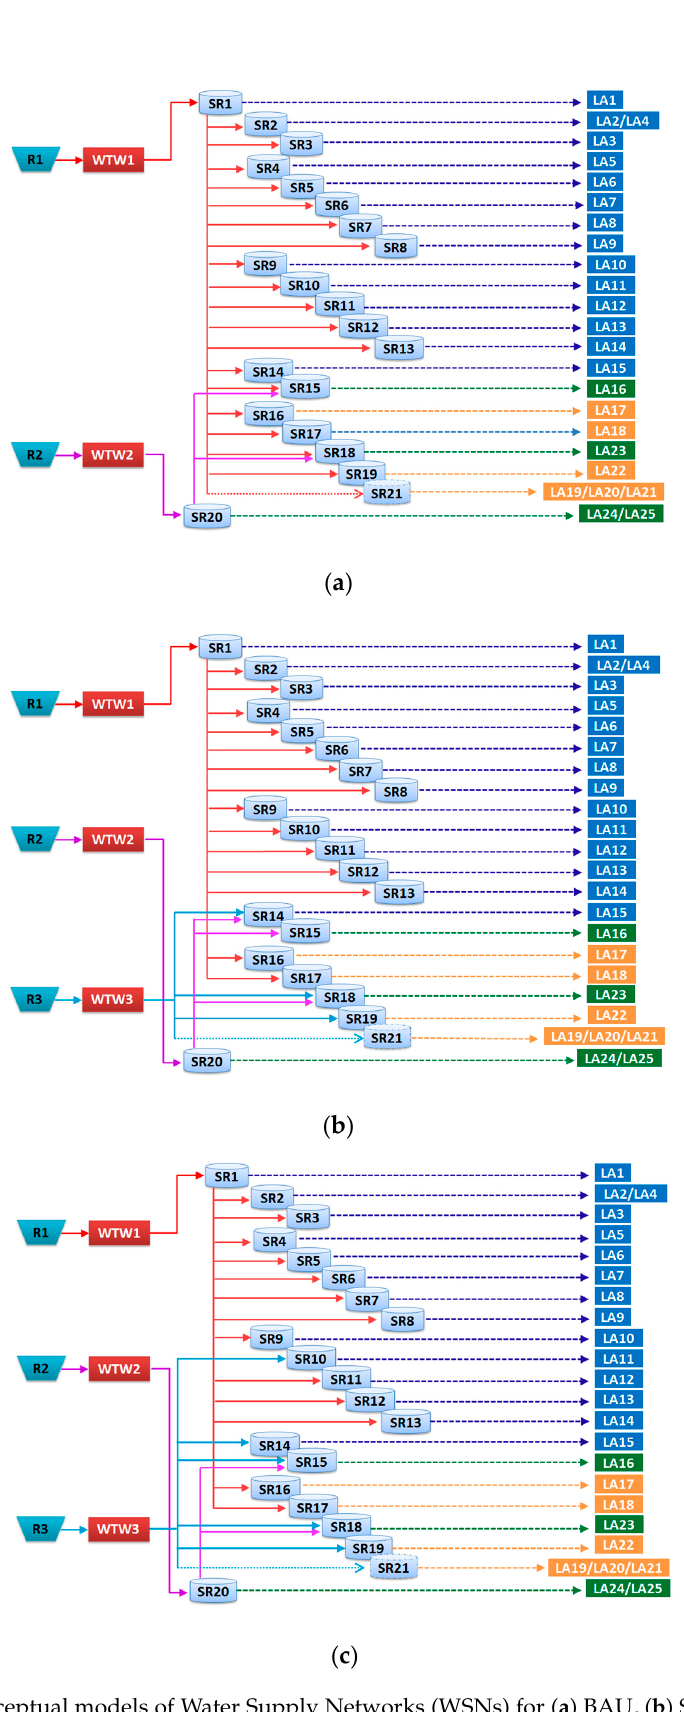
Figure 11. Conceptual models of Water Supply Networks (WSNs) for ( a ) BAU, ( b ) ST1, and ( c ) ST2. Here, R1, R2 and R3 refer to the main well field, i.e., Roncocesi (R1), Luzzara (R2), and (R3) Guastalla. Table 7. Split coefficients between SRs and Water Treatment Works (WTWs) adopted in the BAU and analyzed strategies.